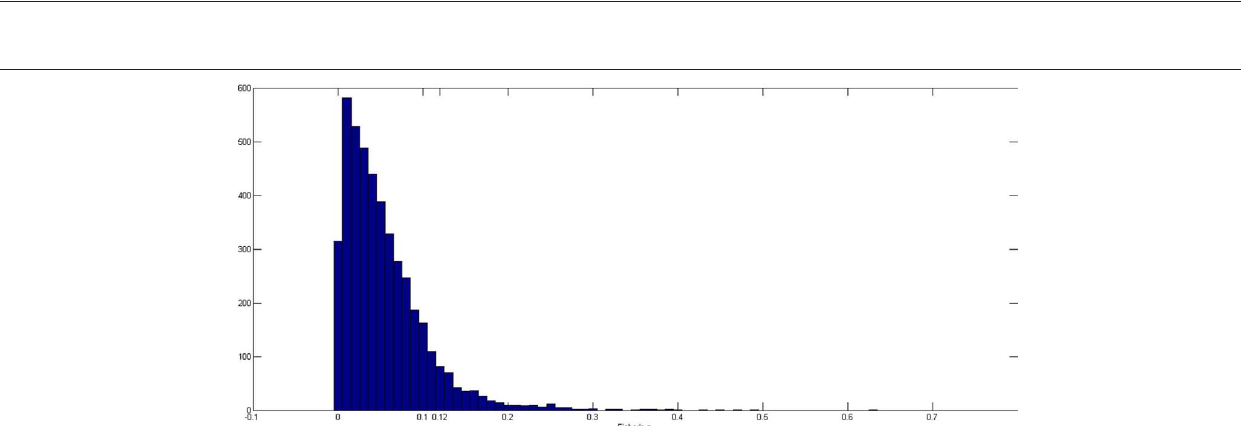
Frontiers in Systems Neuroscience